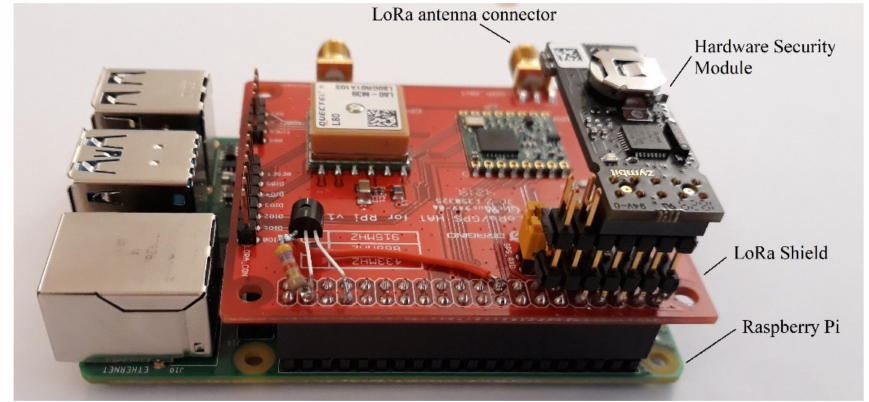
Figure 13. SED sensor hardware without